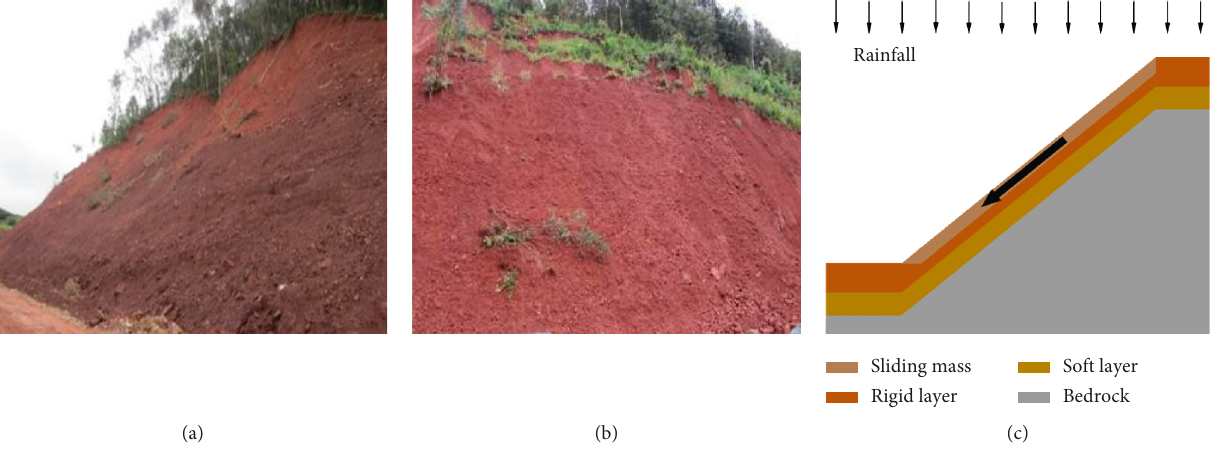
Figure 2: Planar sliding under